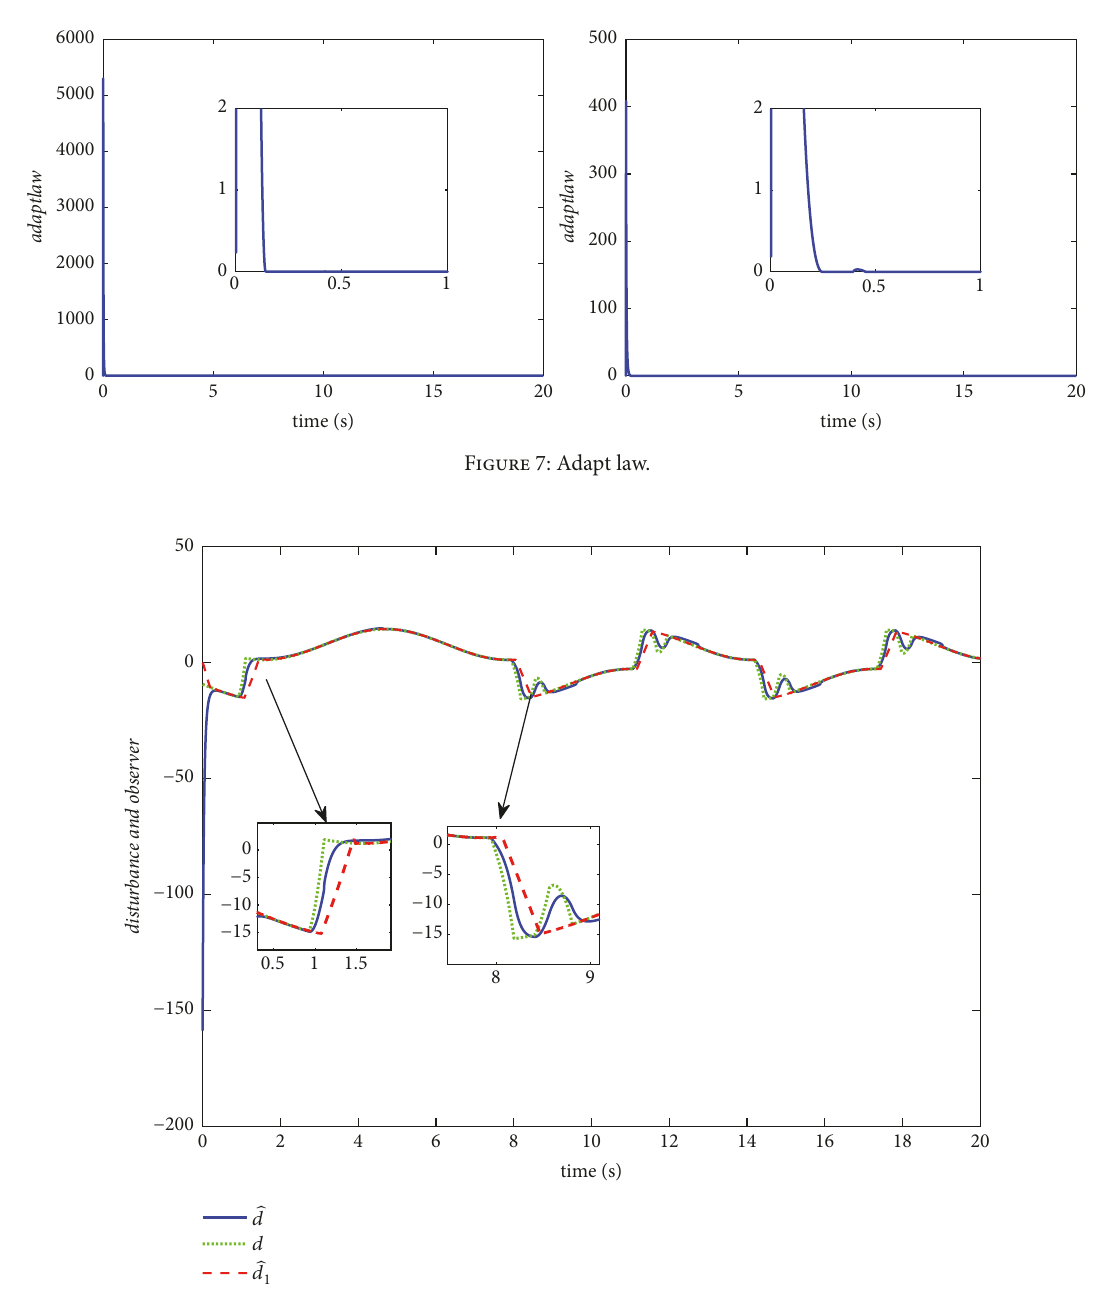
Figure 8: Compound disturbance and its estimate in two observers existing dead-zone